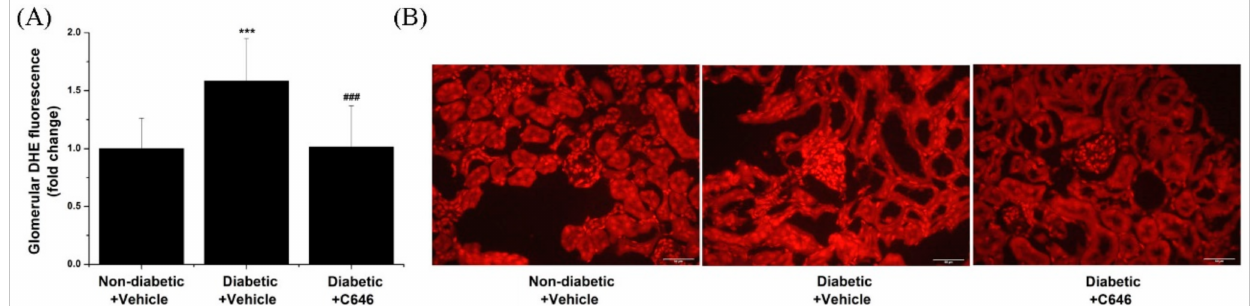
Figure 5. Histone acetyltransferase p300/CBP-dependent induction of in situ glomerular production of ROS in diabetic mice. ( A ) Quantification of glomerular intensity of ROS-induced DHE specific fluorescence signal. ( B ) Representative fluorescence microscopy images (40 × magnification) depicting the down-regulatory effects of p300/CBP pharmacological blockade on glomerular ROS formation. n = 17–21/condition quantified glomeruli, *** p < 0.001, p -values taken in relation to non-diabetic + vehicle condition; ### p < 0.001, p -values taken in relation to diabetic + vehicle